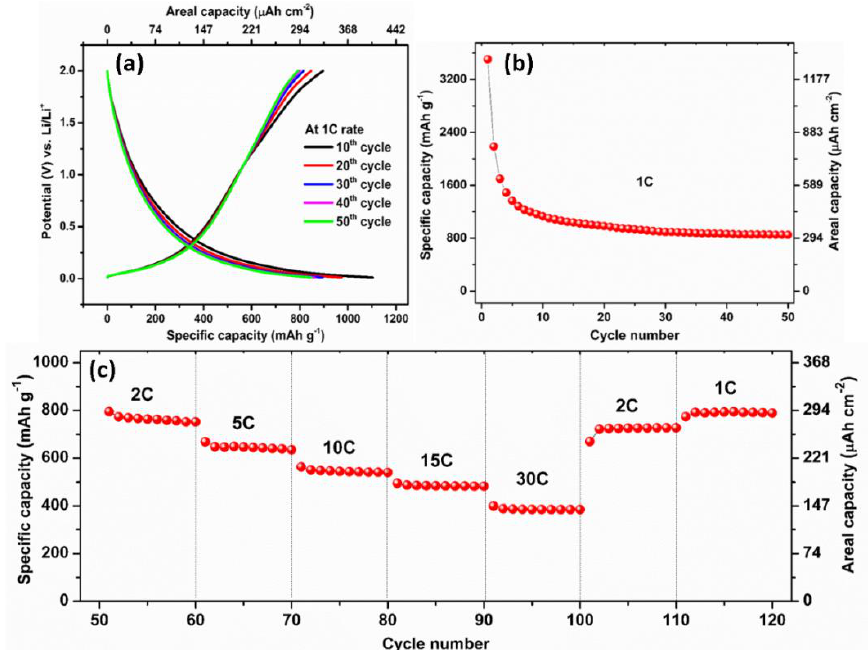
Figure 7. Typical galvanostatic charge–discharge potential profiles vs. Li / Li + for the 10th, 20th, 30th, 40th, and 50th cycle against the capacity of the pre-lithiated CNT electrode for 15 min at 1 C rate ( a ), rate capabilities of the pre-lithiated CNT electrode for 15 min at 1 C rate ( b ) and multiple C-rates ( c ).